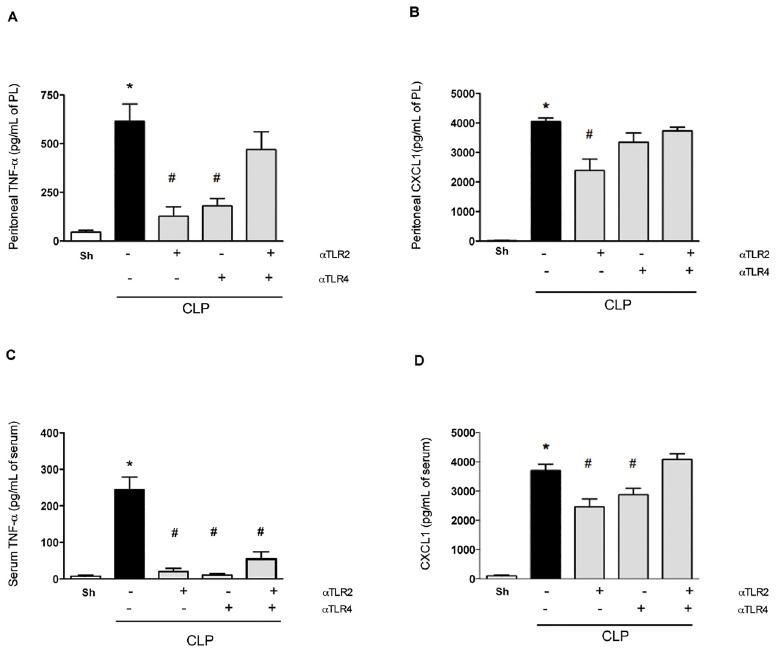
Fig 3. Blockade of either TLR2 or TLR4 reduces TNF- α and CXCL1 levels after polymicrobial sepsis. Mice were pre-treated with individual or combined anti-TLR2 or anti-TLR4 antibodies (45 minutes before the CLP procedure). Single treatment resulted in lower levels of TNF- α and CXCL1 (A and B, respectively) in the peritoneal cavity (PL: peritoneum lavage) and in serum (C and D, respectively) 6 hours after sepsis compared to the negative control isotype IgG antibody treatment (black bar). The combined treatment with both anti- TLR2 and anti-TLR4 presented similar response compared to negative isotype IgG treated-group. * p < 0.05 between the CLP and Sham groups. # p < 0.05 between the antibody treatment groups and negative control isotype IgG treated-group. Antibody dose (1 mg/animal). Used 6 animals/group, except isotype IgG antibody treated group (n =